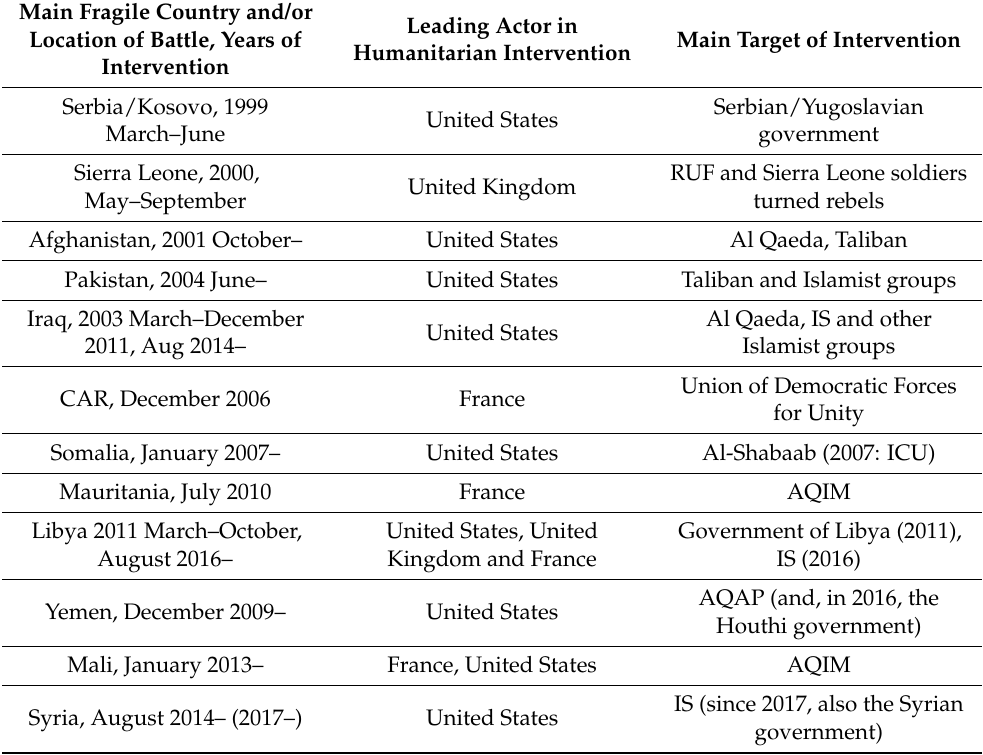
Table 1. List of protective